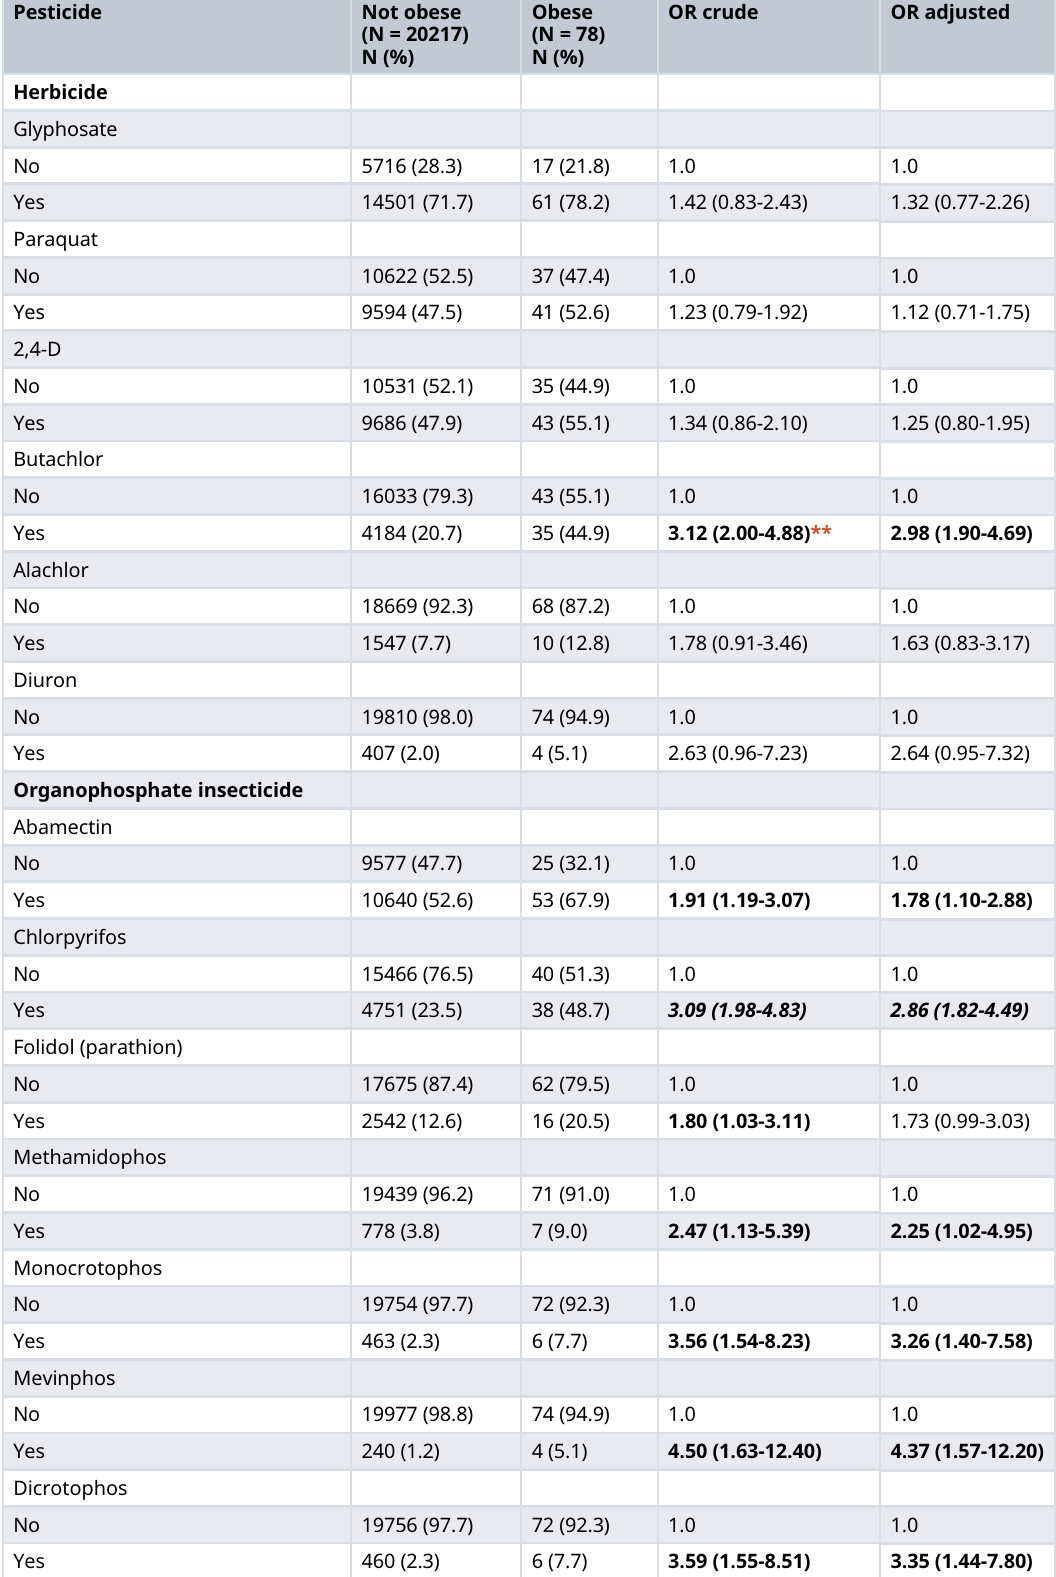
Table 3. Association (OR) between individual pesticide and obesity.